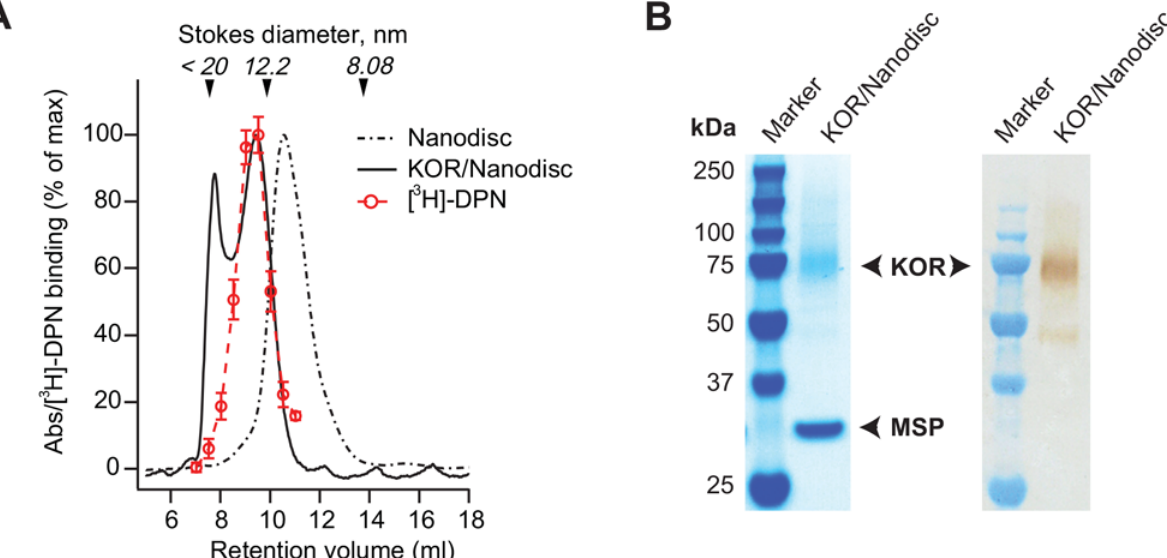
Fig 2. Reconstitution of KOR in Nanodiscs. A) SEC chromatogram (Superdex200) representing UV 280 nm traces from resolution of empty Nanodiscs (black dotted line) and of KOR/Nanodisc complexes (black line). KOR/Nanodisc sample eluted as two peaks. The second peak on the chromatogram corresponded to Nanodiscs containing active KOR, confirmed by specific binding of [ 3 H]-DPN (10 nM) to KOR in eluted fractions (red circles). The column was calibrated with standard proteins indicated by arrows. The Stokes diameters of empty Nanodiscs and KOR/Nanodisc complexes were calculated to be 11.9 nm and 14.1 nm respectively. B) SDS-PAGE detection of KOR reconstituted in Nanodiscs. Left: Coomassie brilliant blue staining, KOR (66 kDa) was visible around (cid:1) 75 kDa while the MSP1E3D1 protein (32.6 kDa) was visible at (cid:1) 30 kDa. Right: The presence of KOR was confirmed by western blot detection with streptavidin alkaline phosphatase binding to the C-terminal biotin-tag of KOR. Original uncropped and unadjusted gel and blot can be seen in S2 Fig.